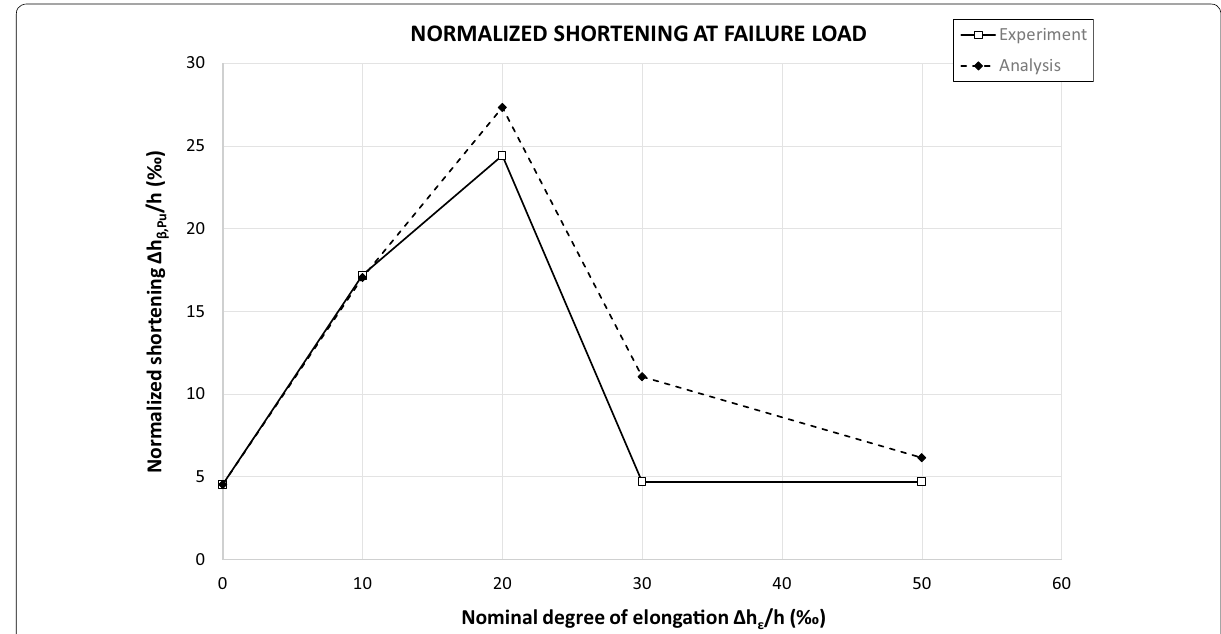
Fig. 15 Comparison of experimental and analytical diagrams of normalized shortening at failure for specimens of the current work.